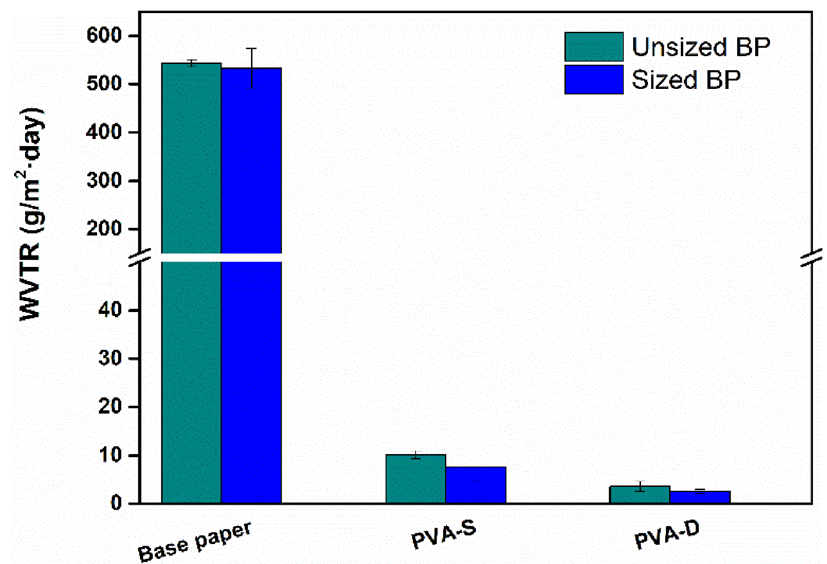
Figure 3. WVTR of papers. S: single coating; D: double coating; BP: base